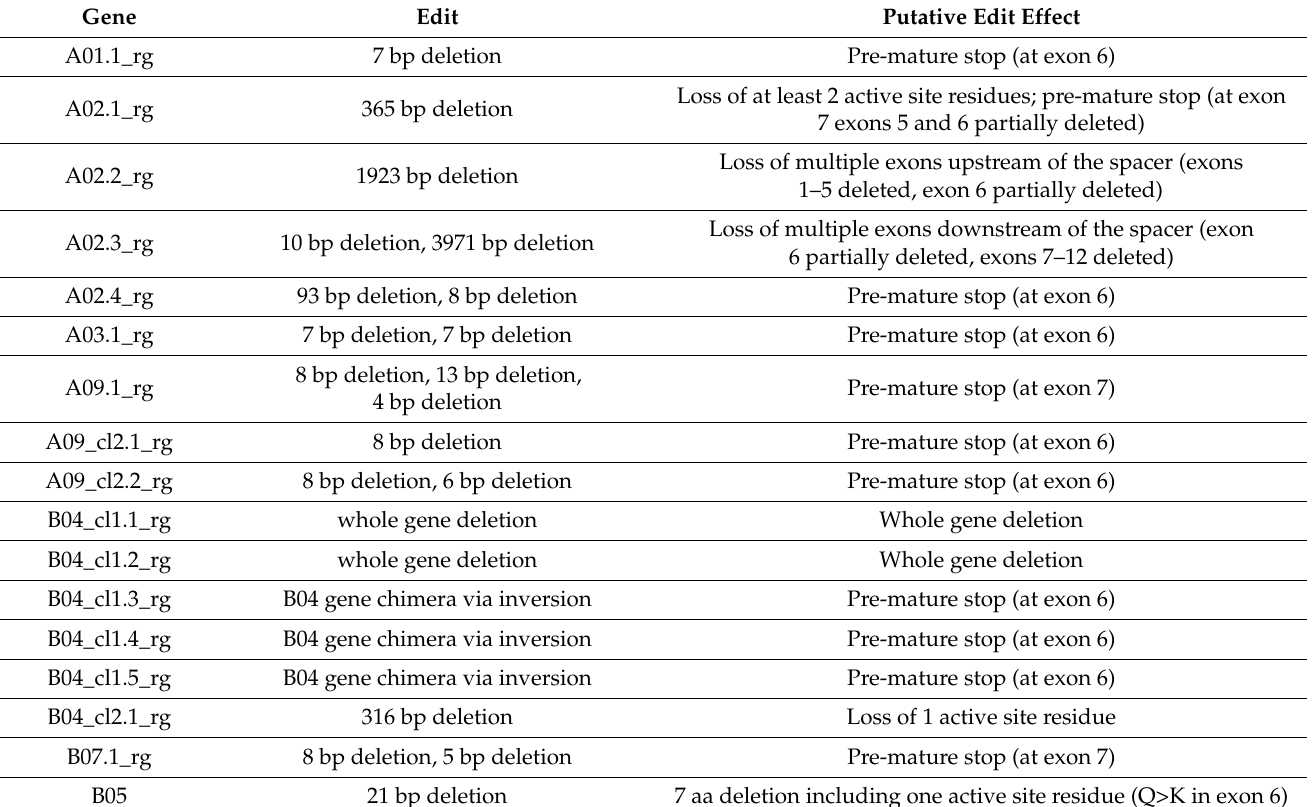
Table 1. Edit allele characterization at myrosinase loci in the homozygous E n Red Giant